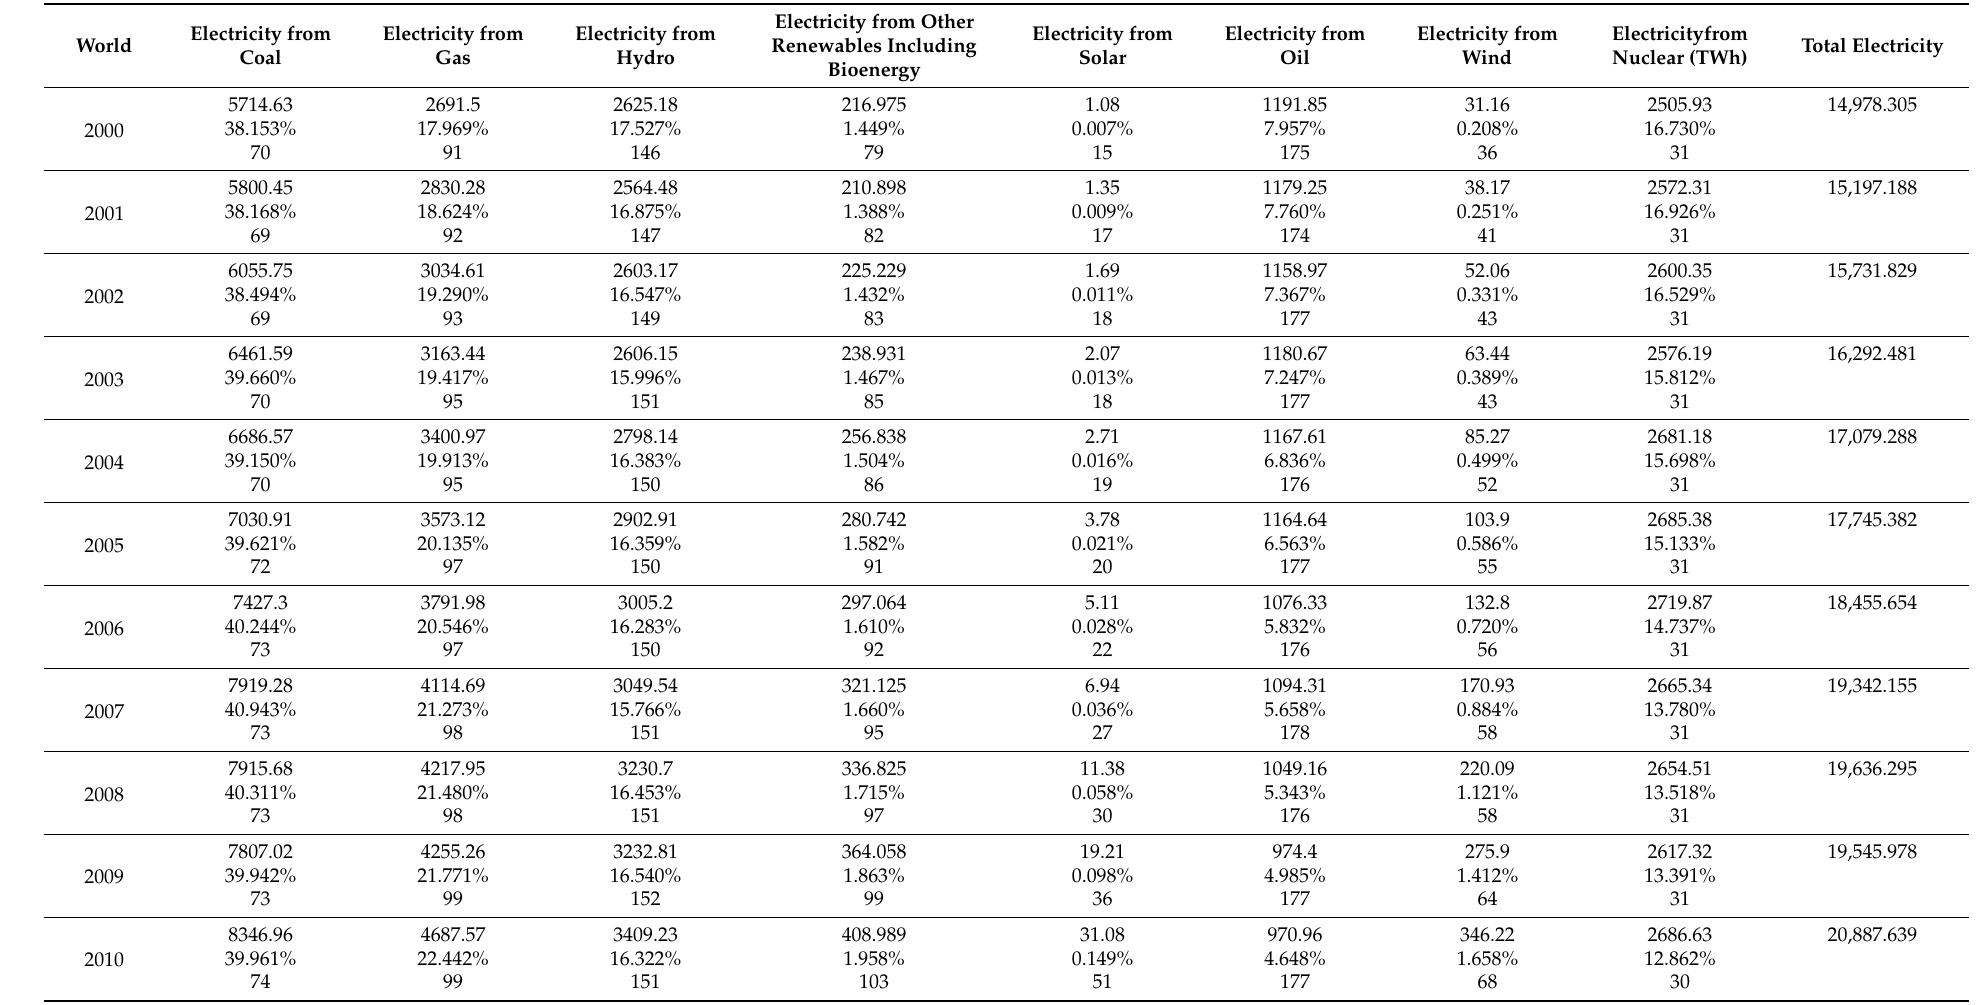
Table A2. Sources of Produced Electricity (all in